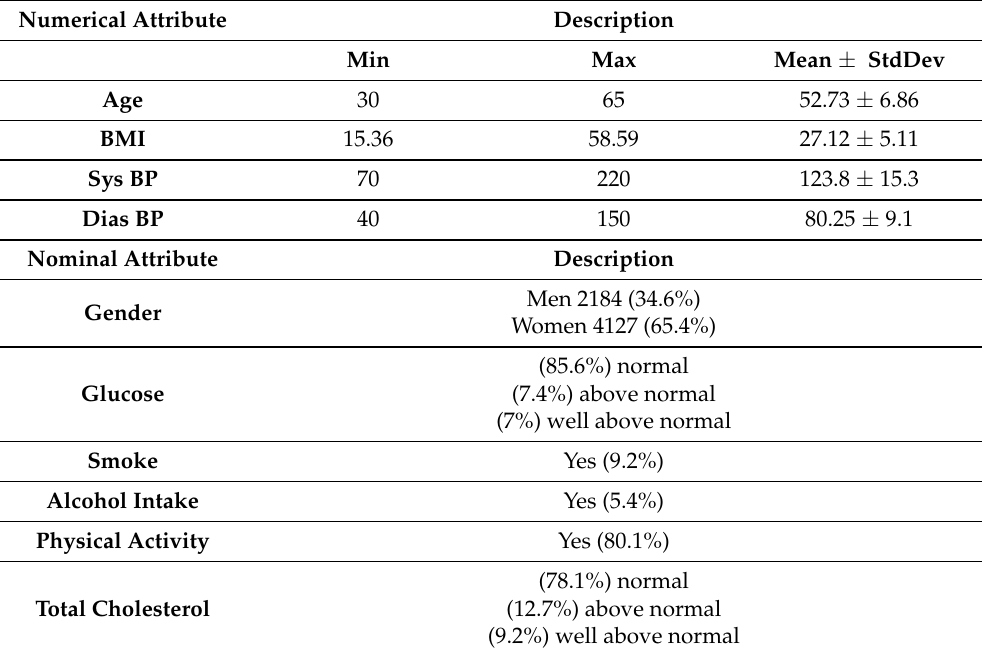
Table 1. Numerical and nominal features’ description in the unbalanced